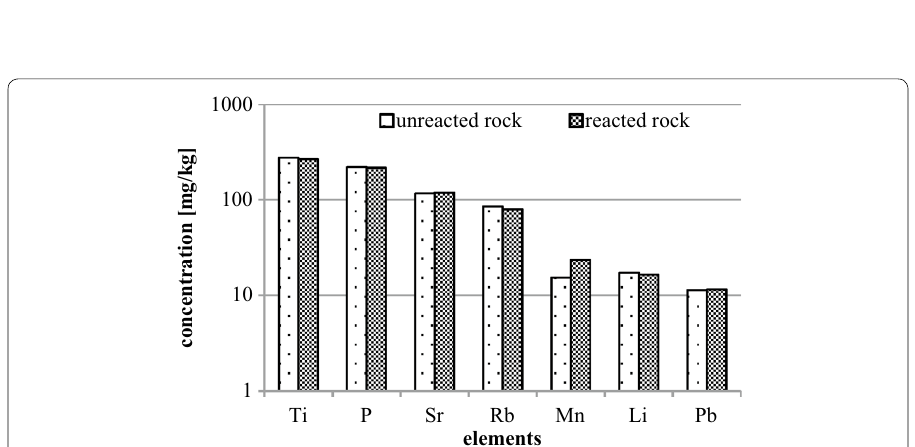
Fig. 21 Trace element content of the initial sandstone sample 7 and the reacted sandstone sample